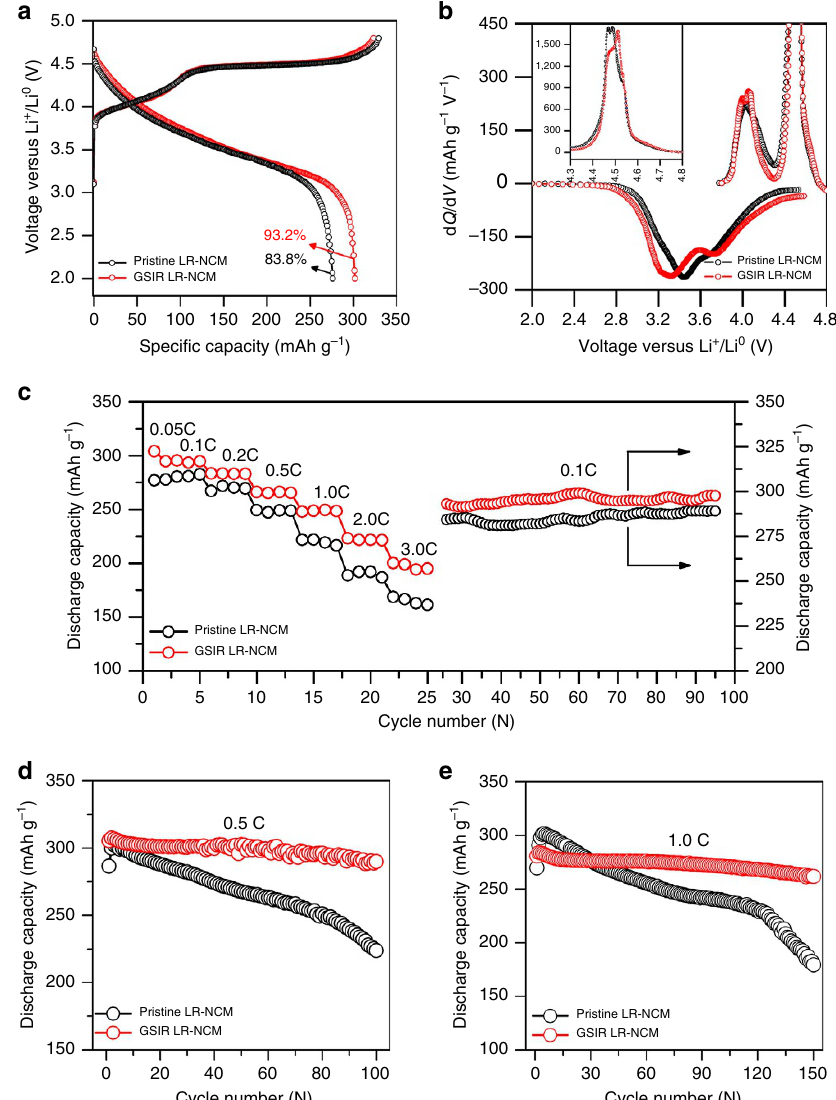
Figure 4 | Charge–discharge characteristics of the pristine and GSIR LR-NCM. ( a ) First charge–discharge profiles of the pristine and GSIR LR-NCM obtained from a 2032-type coin cells at 0.05 C-rate, where 1.0 C-rate corresponds to the current density of 250mAg (cid:2) 1 . ( b ) Differential capacity (d Q/ d V ) plots of the initial cycle curves of the pristine and GSIR LR-NCM. The inset shows the enlarged d Q/ d V curves about 4.5V. ( c ) Discharge-rate capacity after charging galvanostatically at 0.1 C-rate before each discharge. The capacity retention when performing charge–discharge cycles at constant 0.1 C-rate for 70 cycles after all rates tested. ( d , e ) Cycling performance of the pristine and GSIR LR-NCM at 55 (cid:2) C by applying a constant current density of 0.5 C-rate and 1.0 C-rate (250mAg (cid:2) 1 ), respectively. The loading density of the active material on the electrode was around 5.5mgcm (cid:2) 2 . It is noticeable that the electrochemical data are derived from the average value of at least five coin cells, and the errors on the specific capacity are about 3mAhg (cid:2) 1